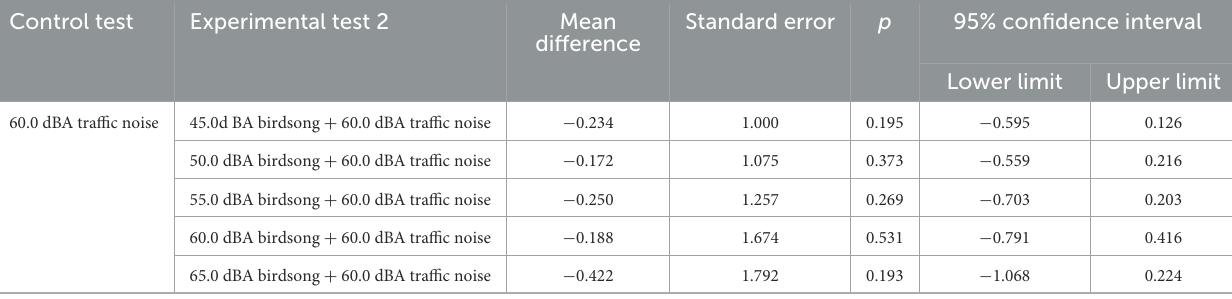
TABLE 4 Comparisons between the psychological health values on the emotional dimension in the control test and experimental test 2.